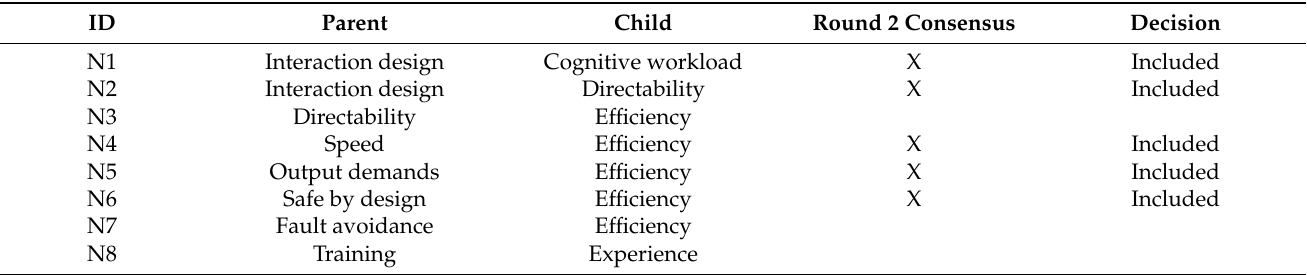
Table 2. Reported relevance in round 2 of relationships proposed in round